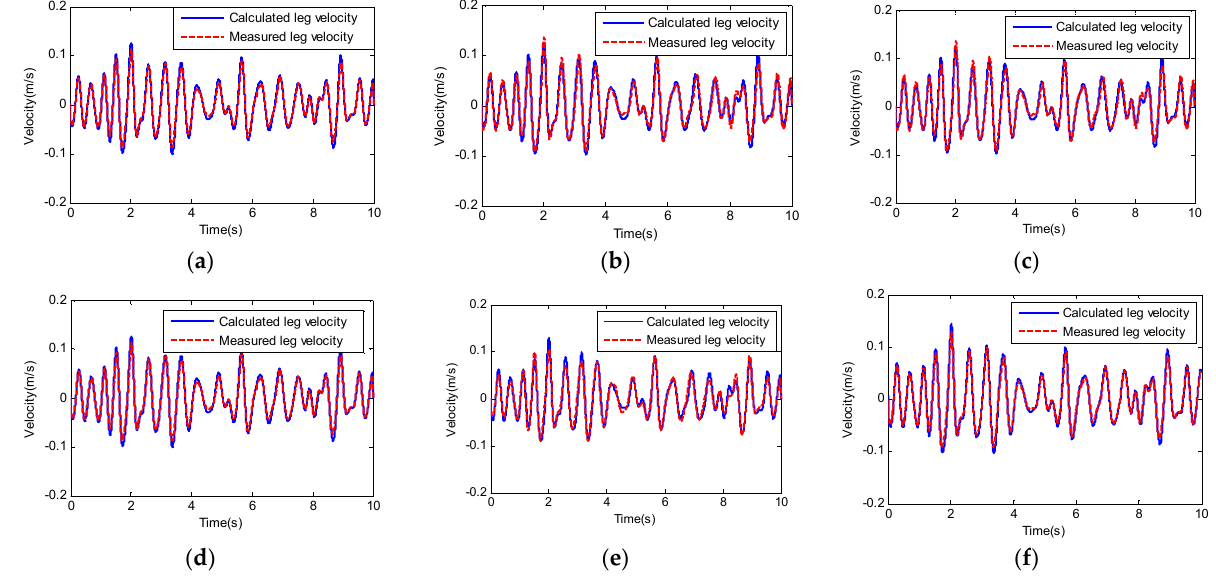
Figure 15. The relative velocities of each leg. ( a ) The velocity of leg1. ( b ) The velocity of leg2. ( c ) The velocity of leg3. ( d ) The velocity of leg4. ( e ) The velocity of leg5. ( f ) The velocity of leg6.